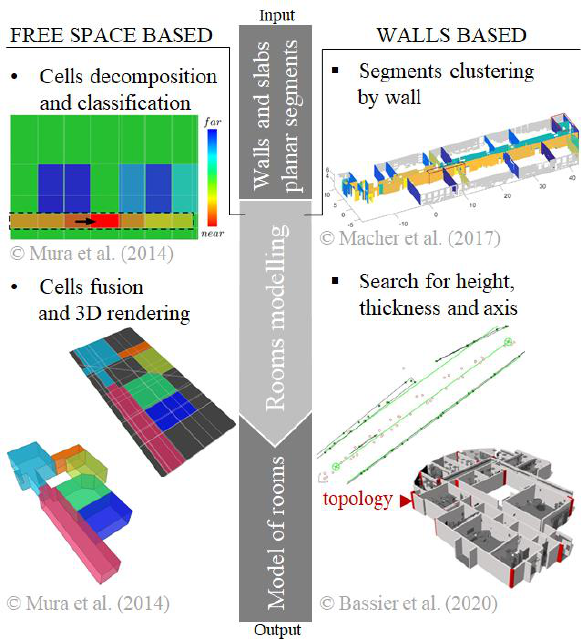
Figure 3. Main rooms modelling workflows: (left) rooms based and (right) walls